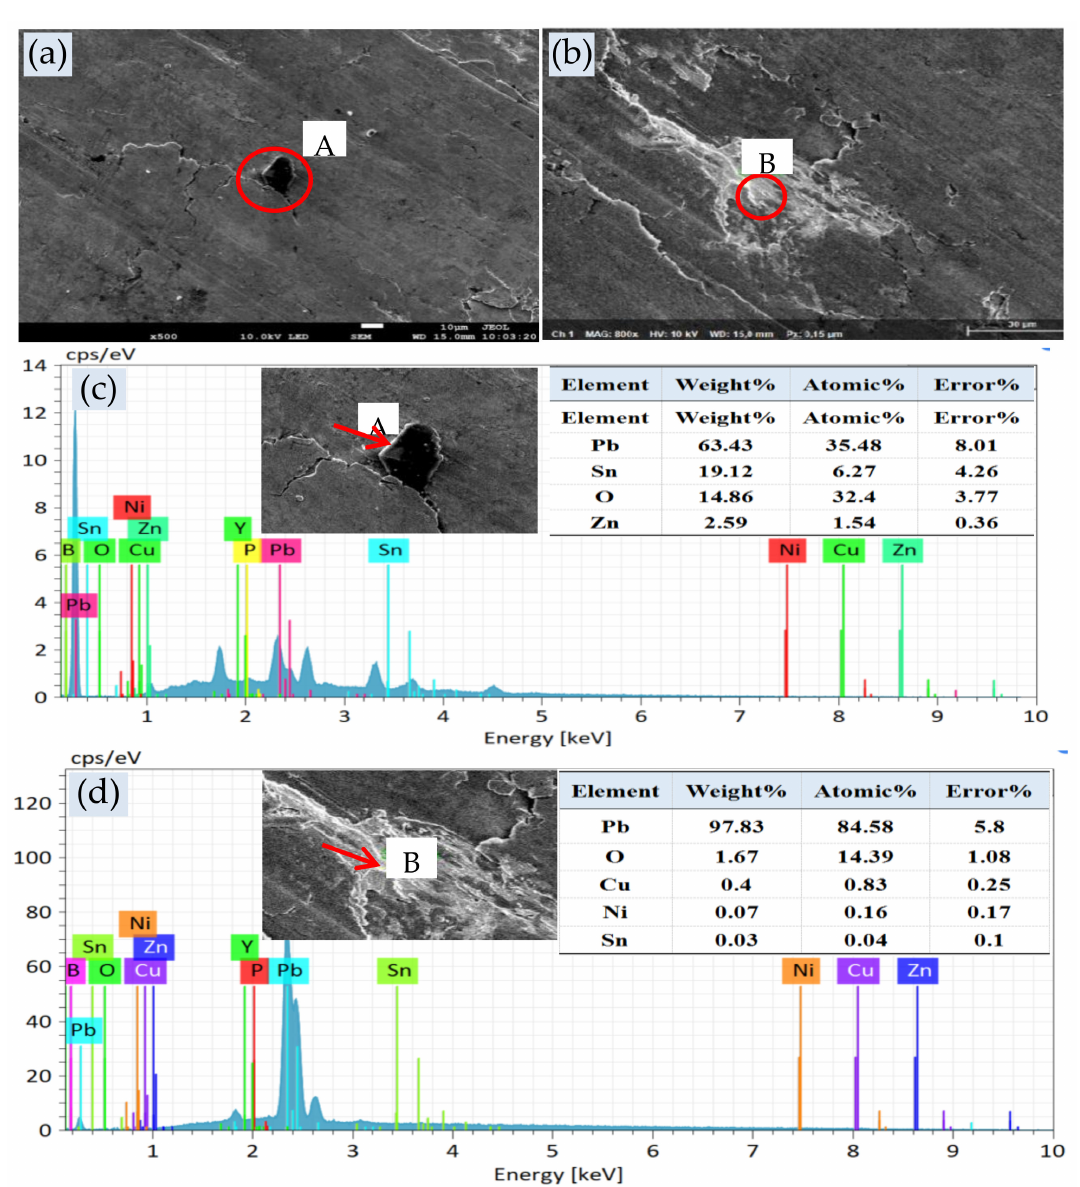
Figure 6. SEM of ZCuPb 20 Sn 5 − 0 P alloy; ( a ) Selection A; ( b ) Selection A; ( c ) EDS of A; ( d ) EDS of B. A is Cu 3 P, and the B is Pb. Figure 7 is the EDS data diagram of the alloy without adding phosphorous